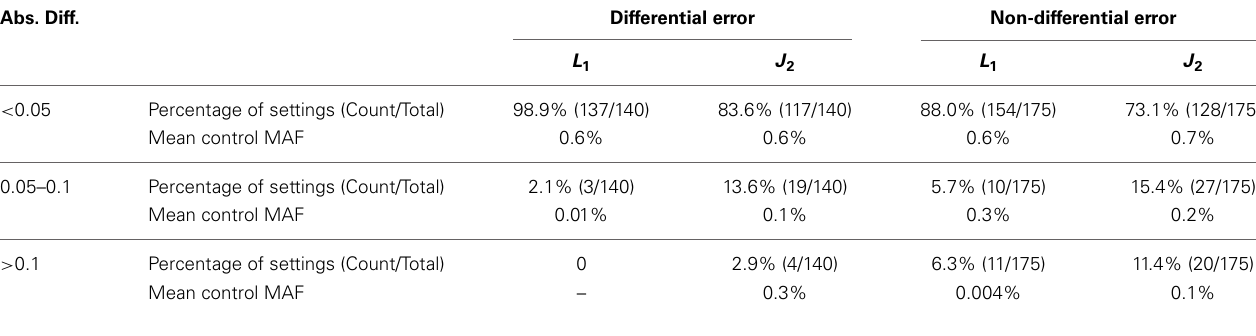
Table 3 | Proportion of simulation settings and average MAF, within each absolute difference subcategory. Abs.